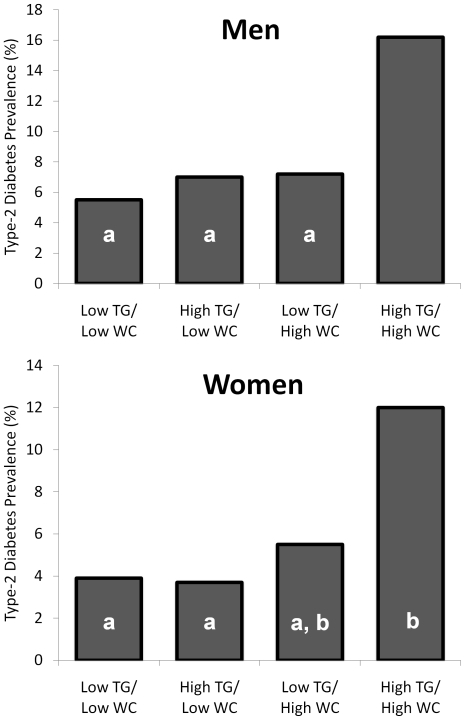
Type-2 diabetes prevalence among HIV-infected men (top panel) and women (bottom panel) according to WC and TG category.Bars represent prevalence (%).Bars with the same inset letter are not statistically different from one another (p>0.05). All other comparisons are significant (p<0.05).